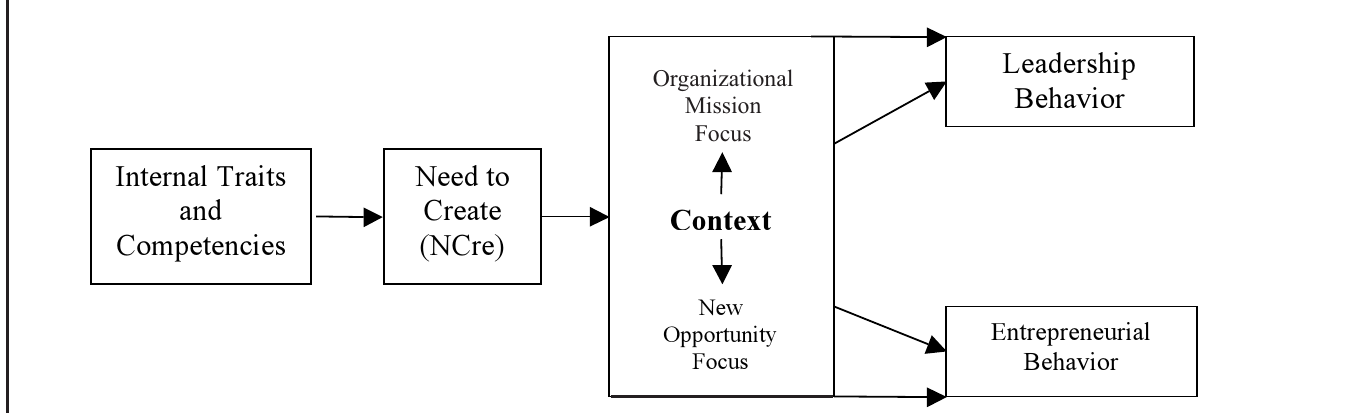
Figure 1. The Role of Internal Traits, NCre, and Context in Determining Leader/Entrepreneur Behavior